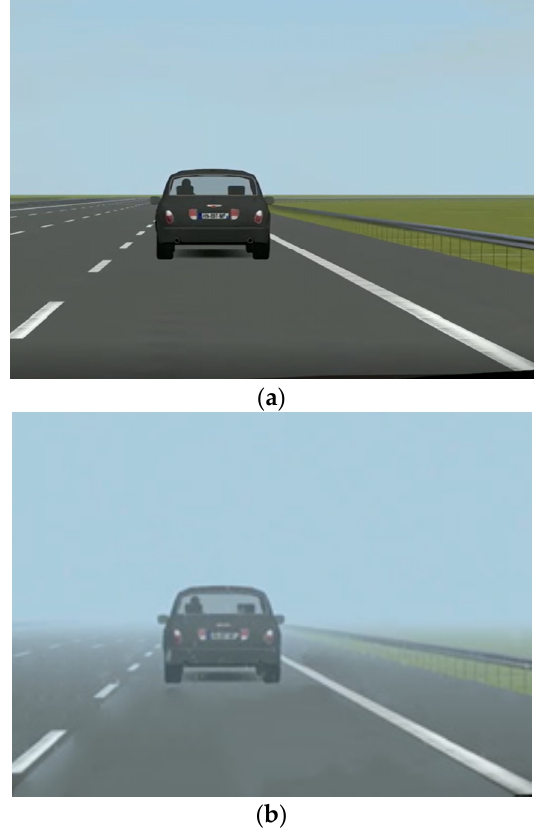
Figure 2. One of the driving scenarios displayed on the screen.